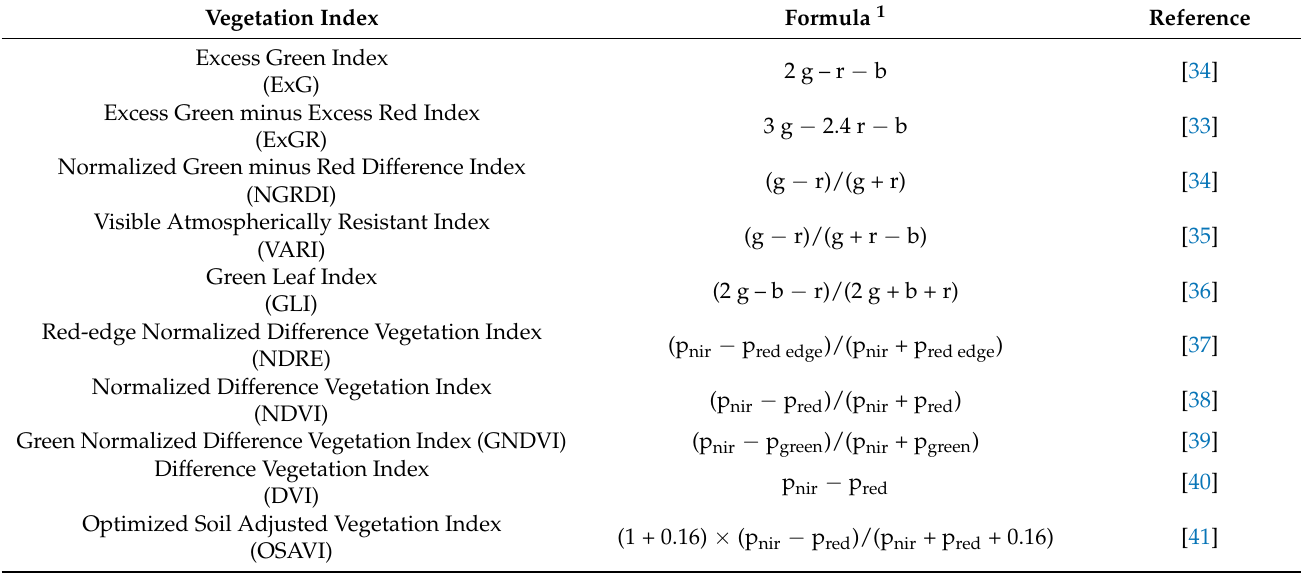
Table 2. Definition of the selected